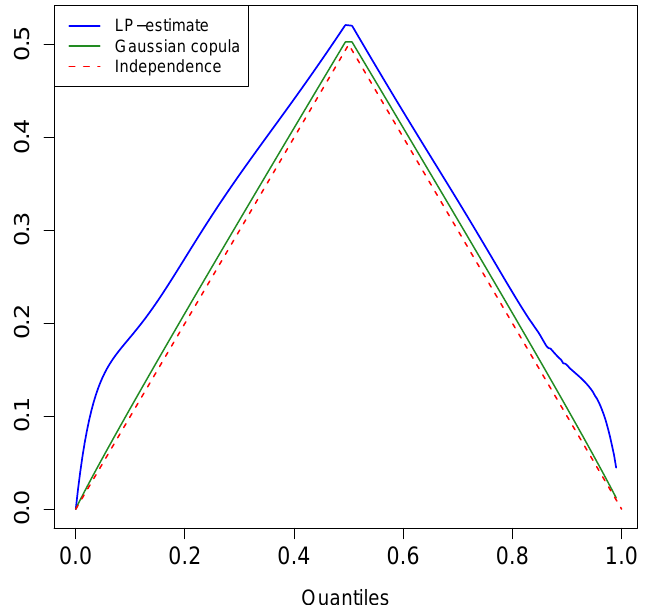
Figure 7. Estimated Quantile Correlation Function ( QCF ) (cid:98) λ LP [ u ; Y ( t ) , Y ( t + 1 )] . It detects asymmetry in the tail dependence between the lower-left quadrant and upper-right quadrant for S&P 500 return data. The red dotted line denotes the quantile correlation function under dependence. The dark green line shows the quantile correlation curve for the fitted Gaussian